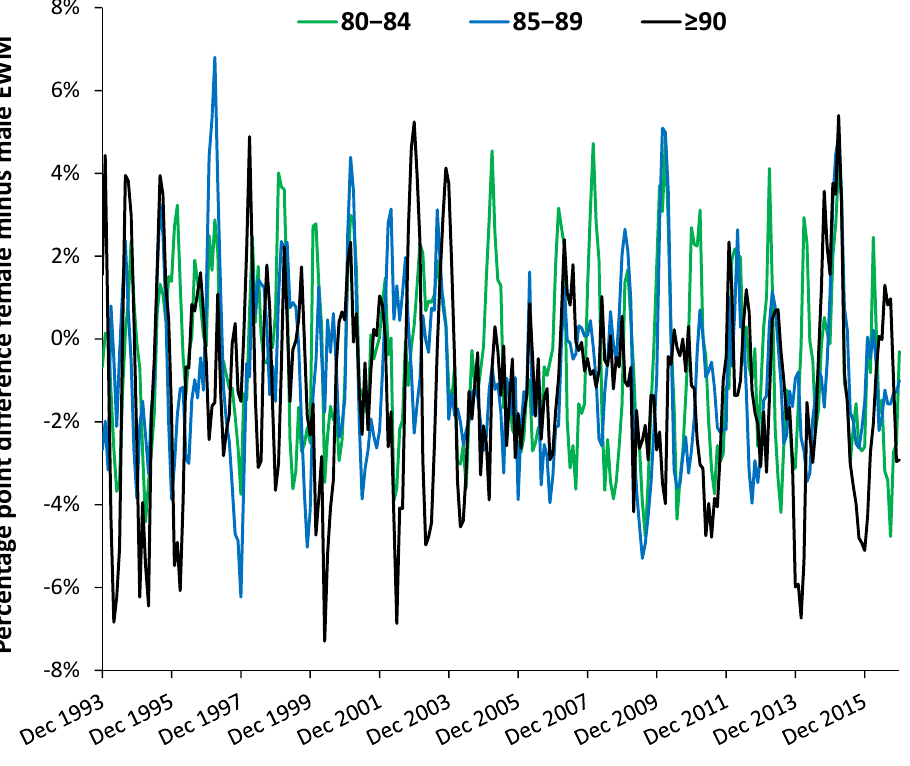
Figure 5. Percentage point difference between female and male EWM (1993/94 to 2015/16) for age bands over 79 years.